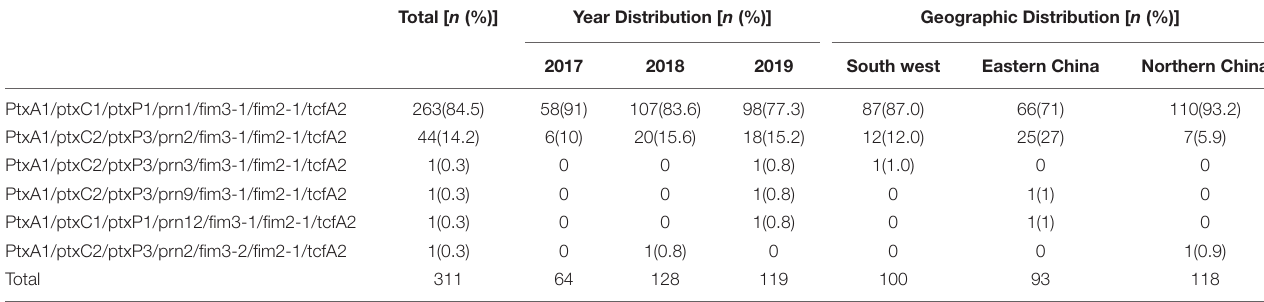
TABLE 3 | Distribution by year and geographic region of the seven virulence-related genotypes among the presented 311 B. pertussis isolates in China,